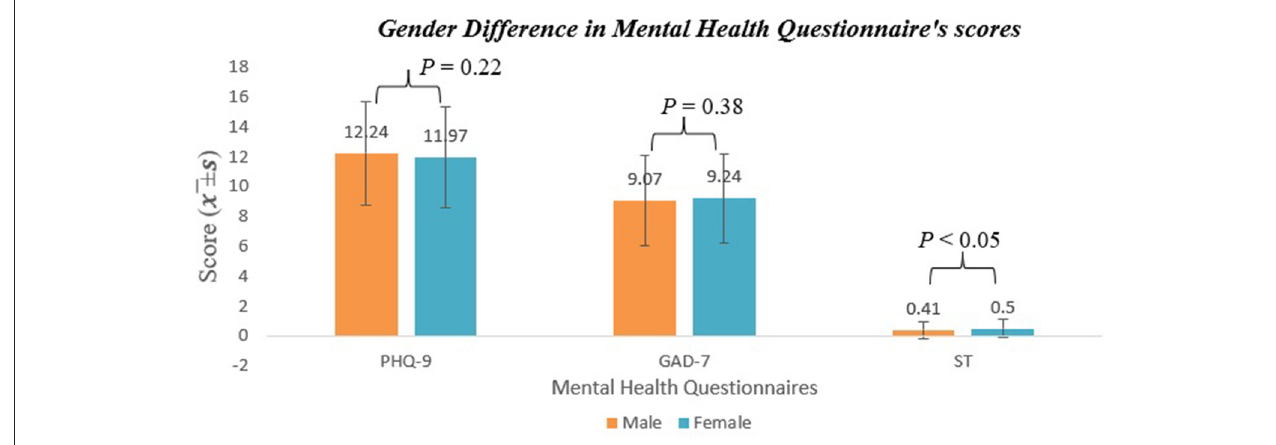
FIGURE 1 | Gender difference in mental health questionnarie’s score.